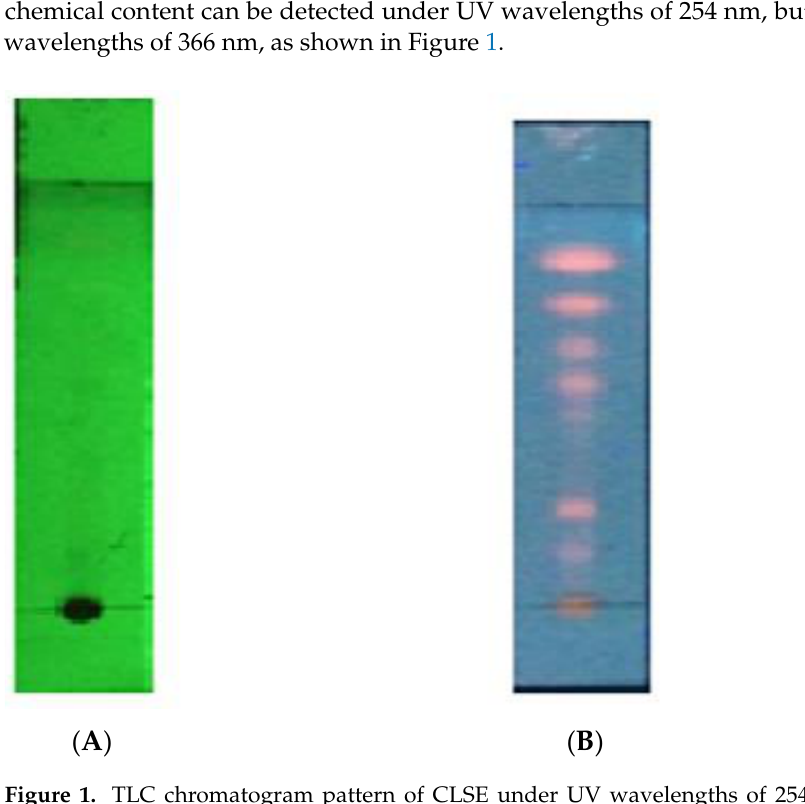
Figure 1. TLC chromatogram pattern of CLSE under UV wavelengths of 254 nm ( A ); and UV wavelengths of 366 nm ( B ).